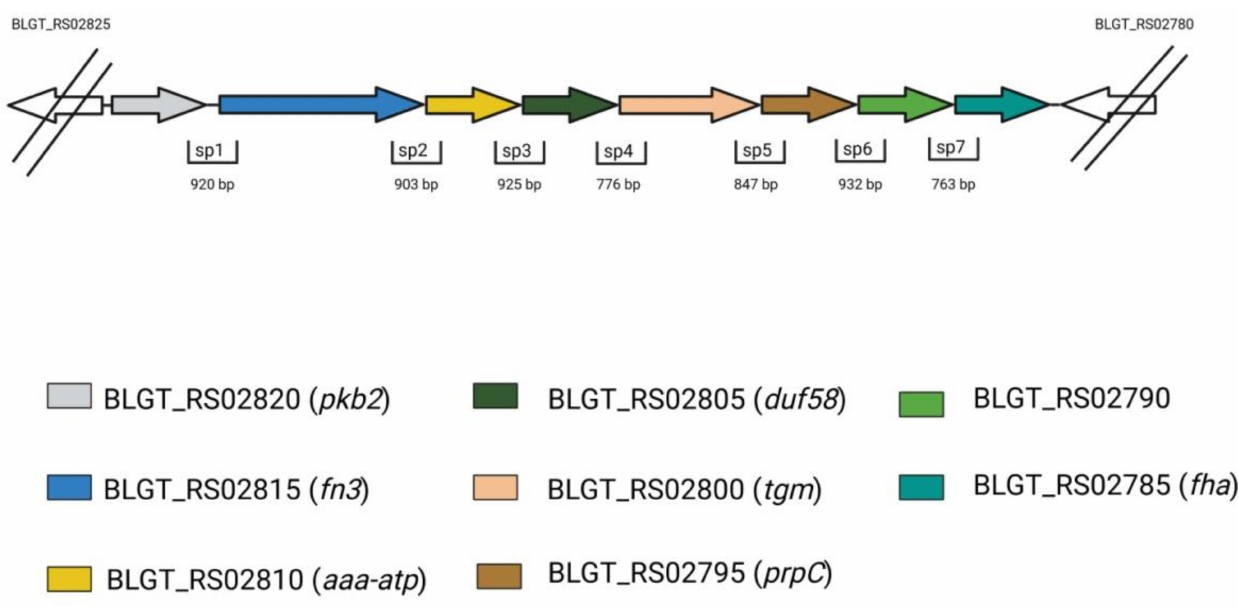
Figure 2. Transcriptional organization of the PFNA operon in B. longum subsp. longum GT15 [61]. Adapted from